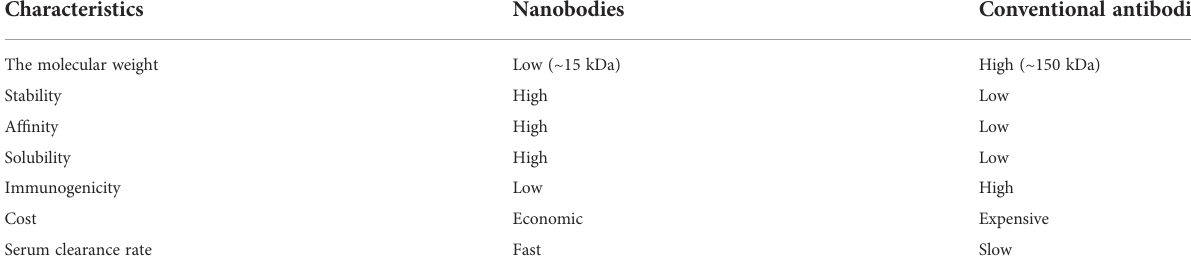
TABLE 1 Characteristics compared between nanobodies and conventional